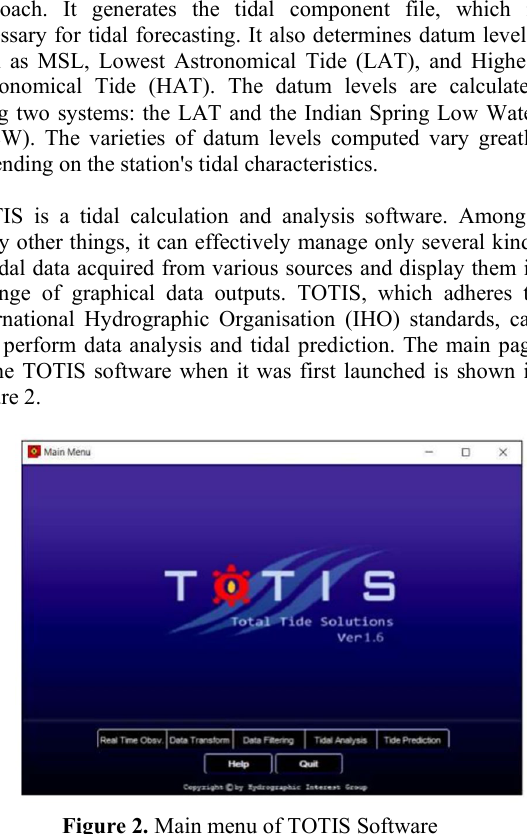
Figure 2. Main menu of TOTIS Software